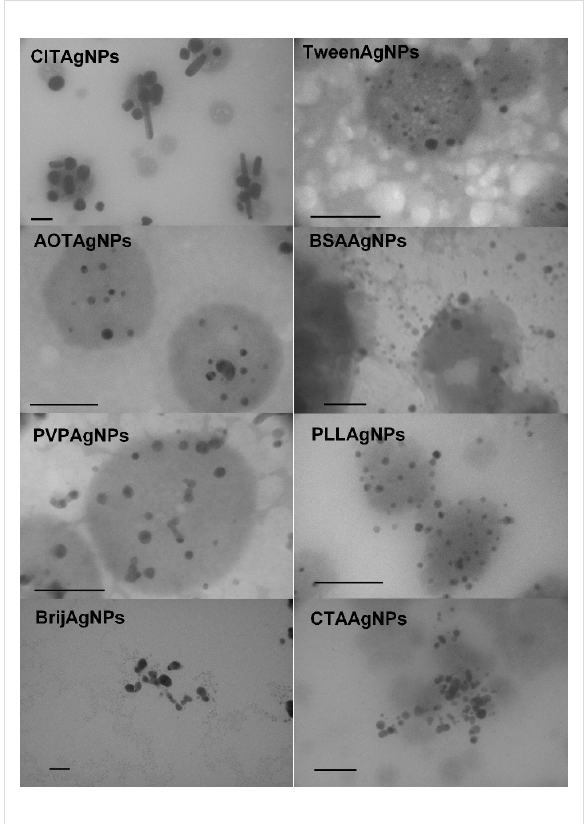
Figure 7: Transmission electron micrographs (TEM) of different silver nanoparticles coated with trisodium citrate (CITAgNP), sodium bis(2- ethylhexyl) sulfosuccinate (AOTAgNP), poly(vinylpyrrolidone) (PVPAgNP), Brij 35 (BrijAgNP), Tween 20 (TweenAgNP), bovine serum albumin (BSAAgNP), poly(L-lysine) (PLLAgNP) , and cetyltri- methylammonium bromide (CTAAgNP) in biological media supple- mented with 0.1% bovine serum albumin (BMP) after 1 h. Scale bars are 100